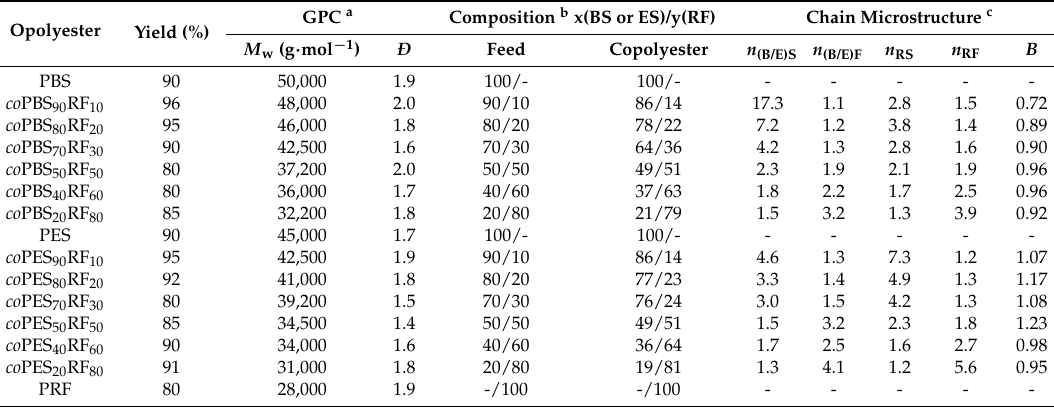
Table 2. Resorcinol-containing Succinate-FuranoateCopolyesters Obtained by ROP. Opolyester Yield (%)